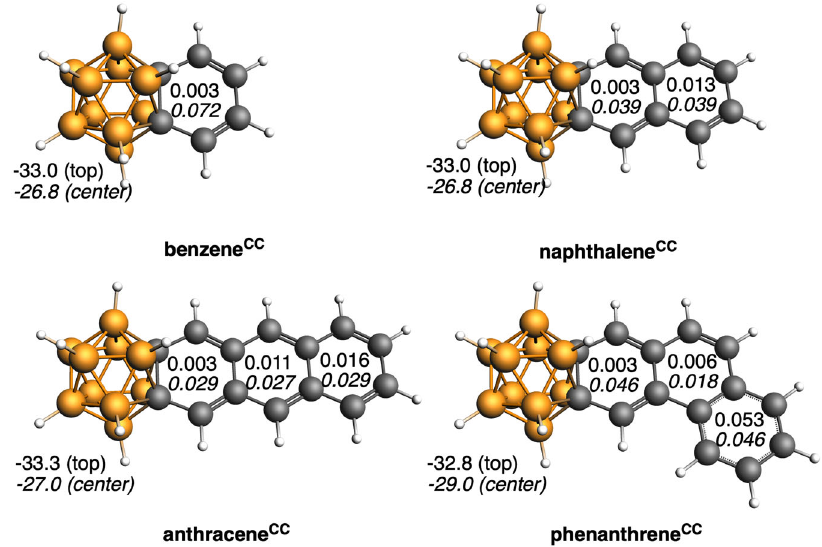
Fig. 8 Fused systems between o -carborane C 2 B 10 H 12 and benzene, naphthalene, anthracene, and phenanthrene. NICS (in ppm) for the fi ve-membered rings and center of the carborane and MCI (in au) for the PAHs with and without (in italics) the carborane being attached (see also Supplementary Tables 1 and 2). Boron atoms in orange, C atoms in gray, and H atoms in white. Larger MCI values indicate higher electron delocalization in the